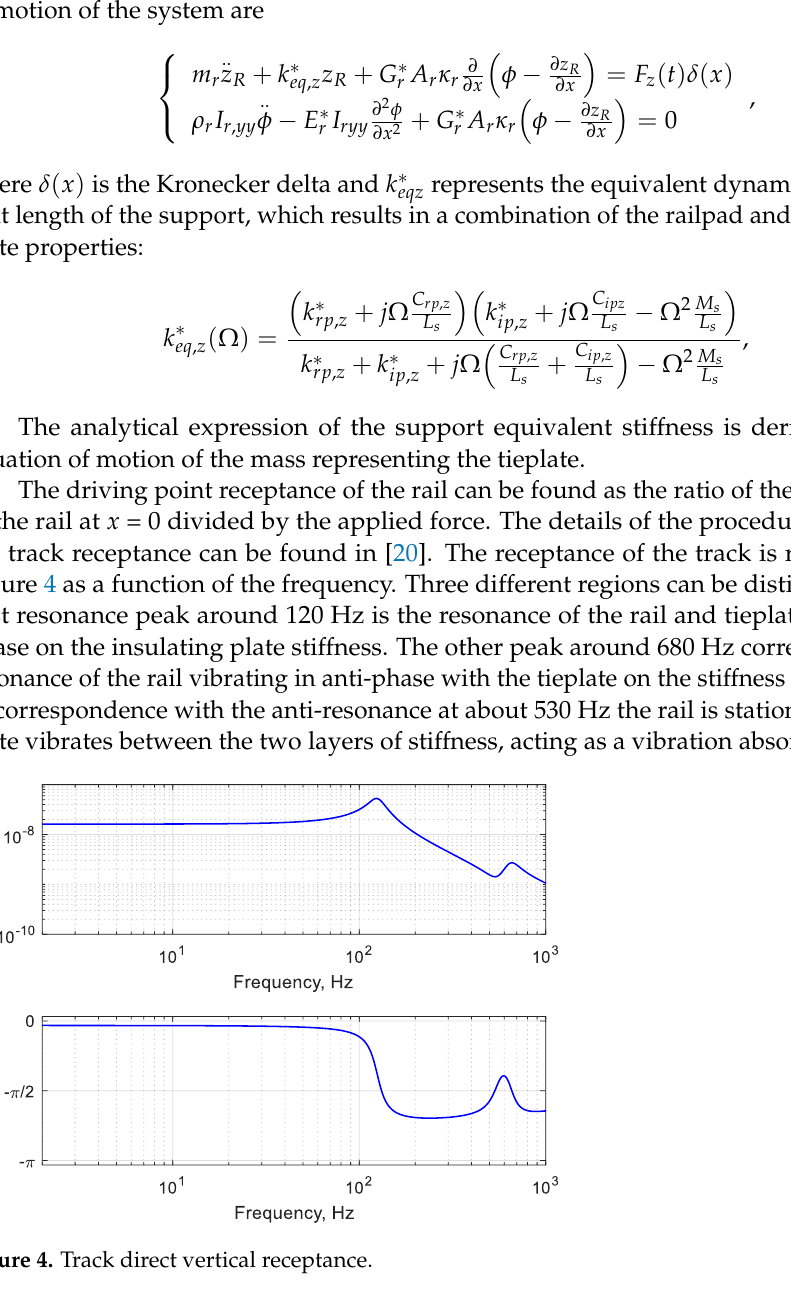
Figure 5. Analytical and experimental direct vertical receptance of the tested track in correspond- ence with a support. Once the support parameters (listed in Table 2) are calibrated on the basis of the ex- perimental data, an equivalent continuously supported track is considered on account of the fact that the variability of track receptance along the span cannot be considered in the present linearised model of the wheel–rail interaction. Figure 6 shows the comparison be- tween the direct receptances calculated with the discrete supports using different excita- tion points and the one obtained by using the continuous support. In the frequency range of interest, the differences between the results using the two different approaches are neg- ligible.